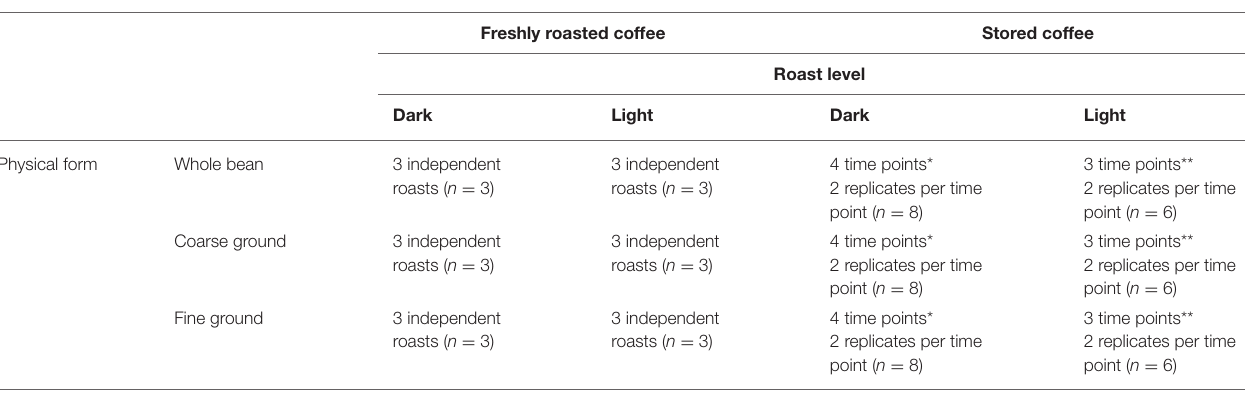
TABLE 1 | Emission test conditions for freshly roasted and stored coffee.